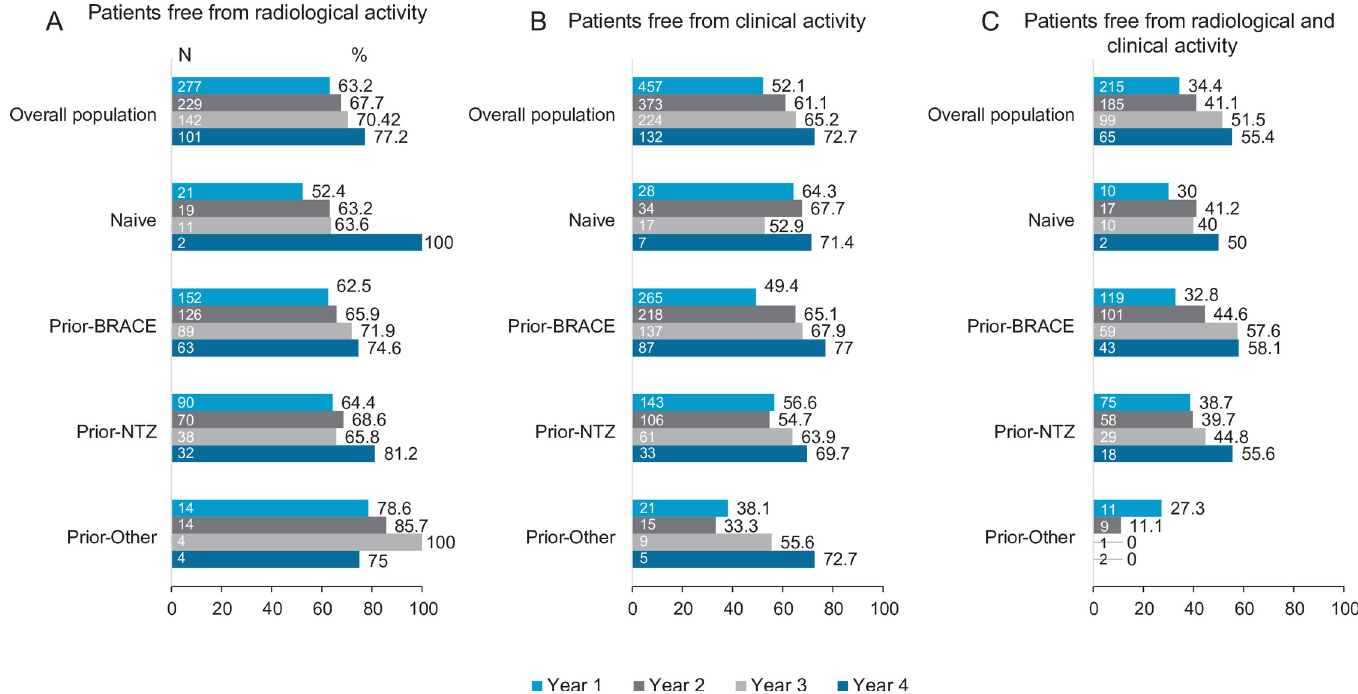
Fig 5. MS activity after 4 years vs prior year of fingolimod treatment in the overall population and prior treatment subgroups. Abbreviatures : BRACE: Betaseron (interferon beta-1b sc), Rebif (interferon beta-1a sc), Avonex (interferon beta-1a im), Copaxone (Glatiramer acetate), and Extavia (interferon beta-1b sc); EDSS, Expanded Disability Status Scale; IQR, interquartile range; N: Number of patients with available data for radiological (A), clinical (B), or radiological and clinical (C) activity; NTZ, natalizumab.